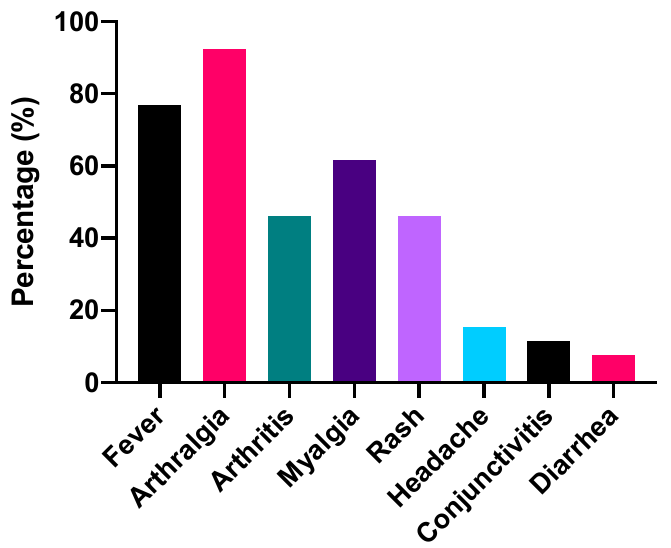
Figure 1. Frequencies of clinical manifestations at the time of presentation ( n = 26).